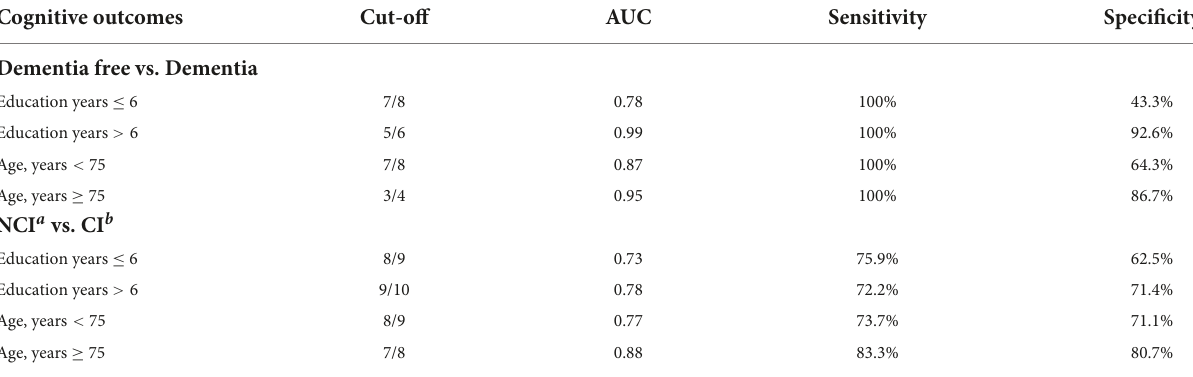
TABLE 3 Diagnostic ability of the DCS in different subgroups. Cognitive